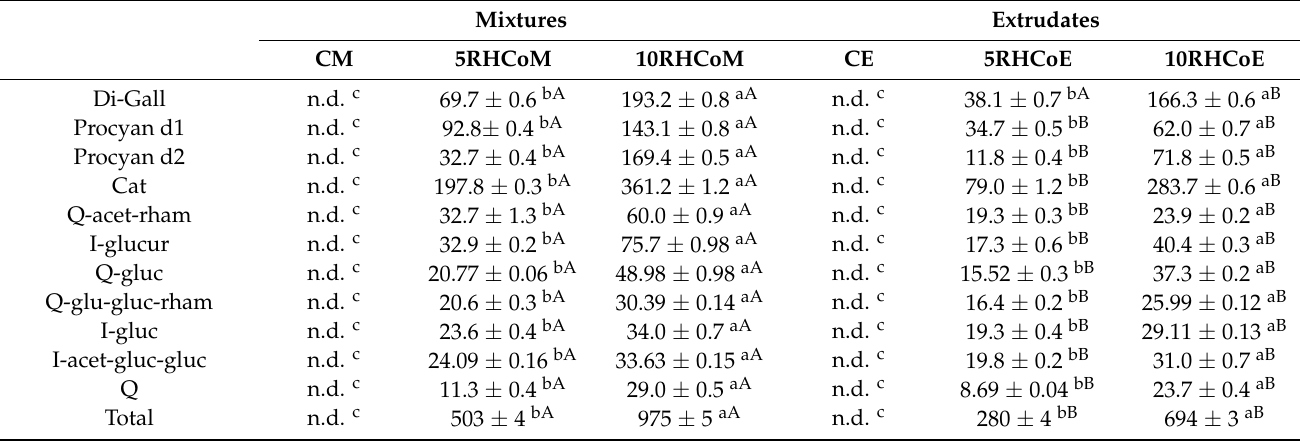
For each parameter, different small letter in superscript within row indicates significant differences between samples ( p < 0.05) comparing samples in mixtures or extrudates. For each sample and parameter, a different capital letter in superscript within row indicates significant differences between samples ( p < 0.05) comparing mixtures and extrudates. Samples were mixtures (M) and extrudates (E); C: Control, 5RHCo: 5% of rosehip co-product and 10RHCo: 10% of rosehip co-product; Di-Gall: Di-Gallic acid; Procyan d1: Procyanidin